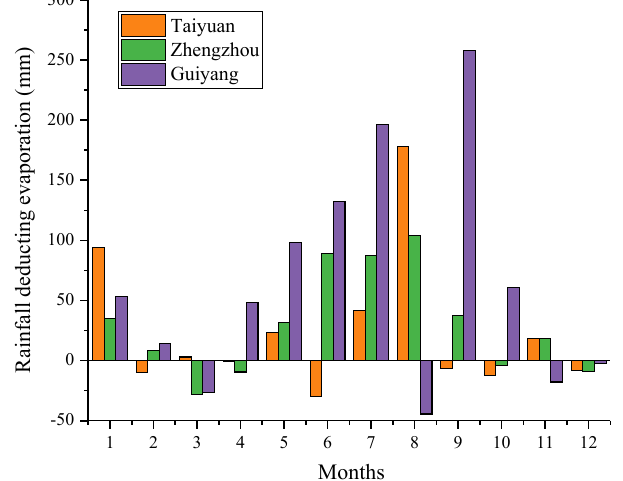
Figure 13. Rainfall deducting evaporation in 2020.